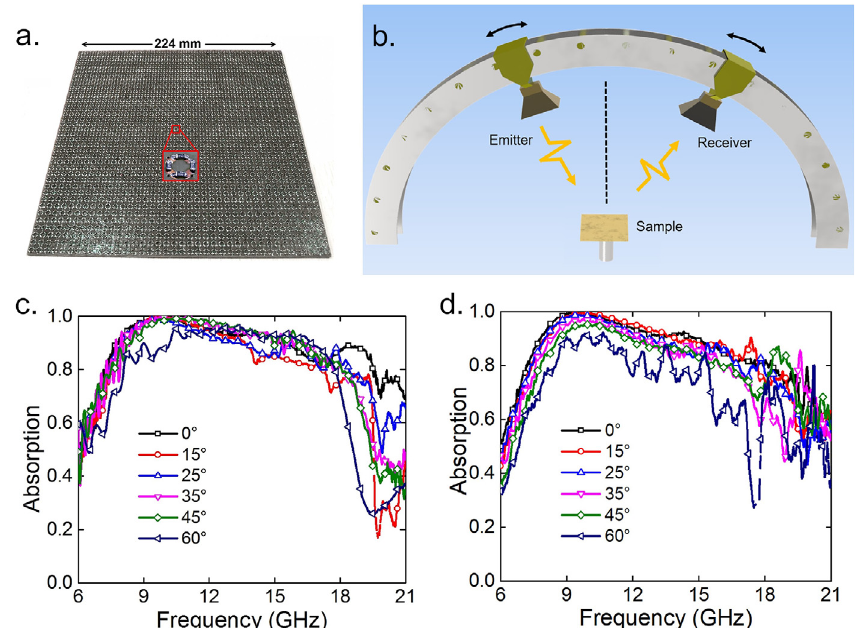
Fig. 6. (a) Photograph of the fabricated metamaterial absorber. The inset shows the enlarged view of a single unit cell. (b) Schematic for the experimental setup for re fl ection measurement. (c) Measured angular performance of absorber under the illumination of TM-polarized incidence. (d) Measured angular performance of absorber under the illumination of TM-polarized